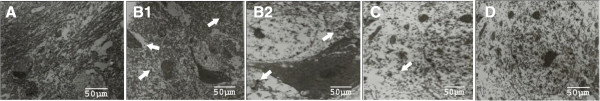
Transmission electron microscopic appearance of midbrain. A: Control (group 1); B1: low resolution of MPTP induced (group II); B2: high resolution of MPTP induced (group II); C: MPTP induced + As treated (group III); D: Drug Control (group IV).